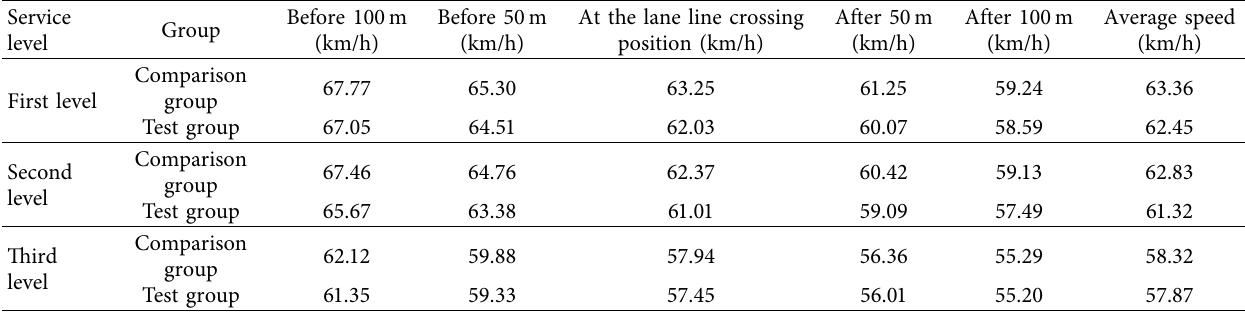
Table 6: Average speeds within 100m before and after the lane change